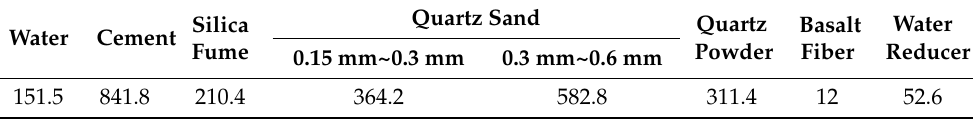
Table 1. Mix proportion of basalt fiber polymer-modified RPC (kg/m 3 ).